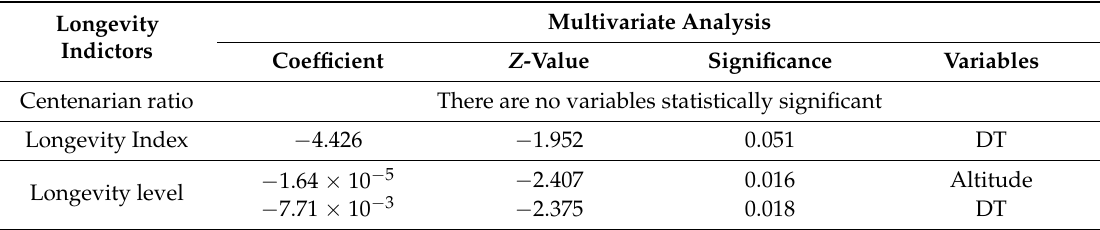
Table 4. Results of GWR between seven longevity indicators and selected natural and socioeconomic indicators (multivariate